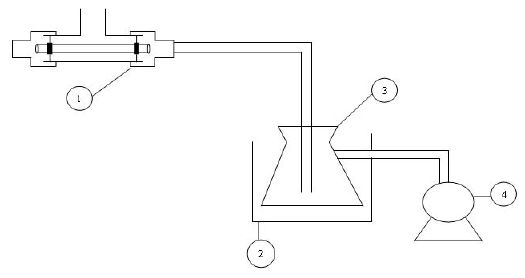
Fig. 3. PV setup (dead end; 1- feed container and PV cell 2- liquid nitrogen trap 3- permeate container 4- three stage vacuum pump